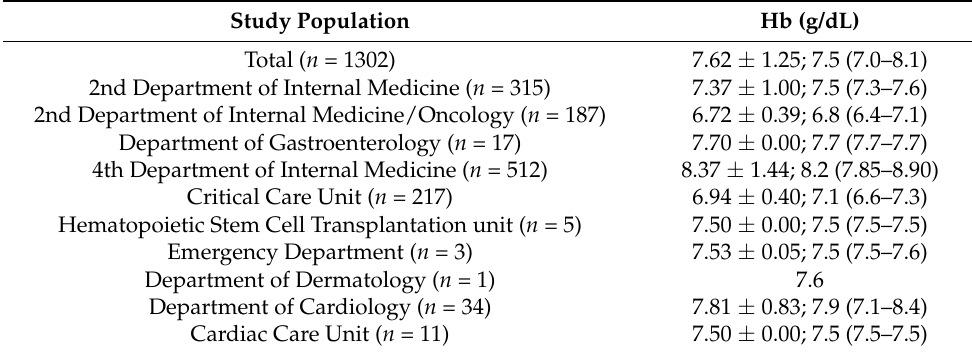
Table 3. Hemoglobin levels of transfused patients with